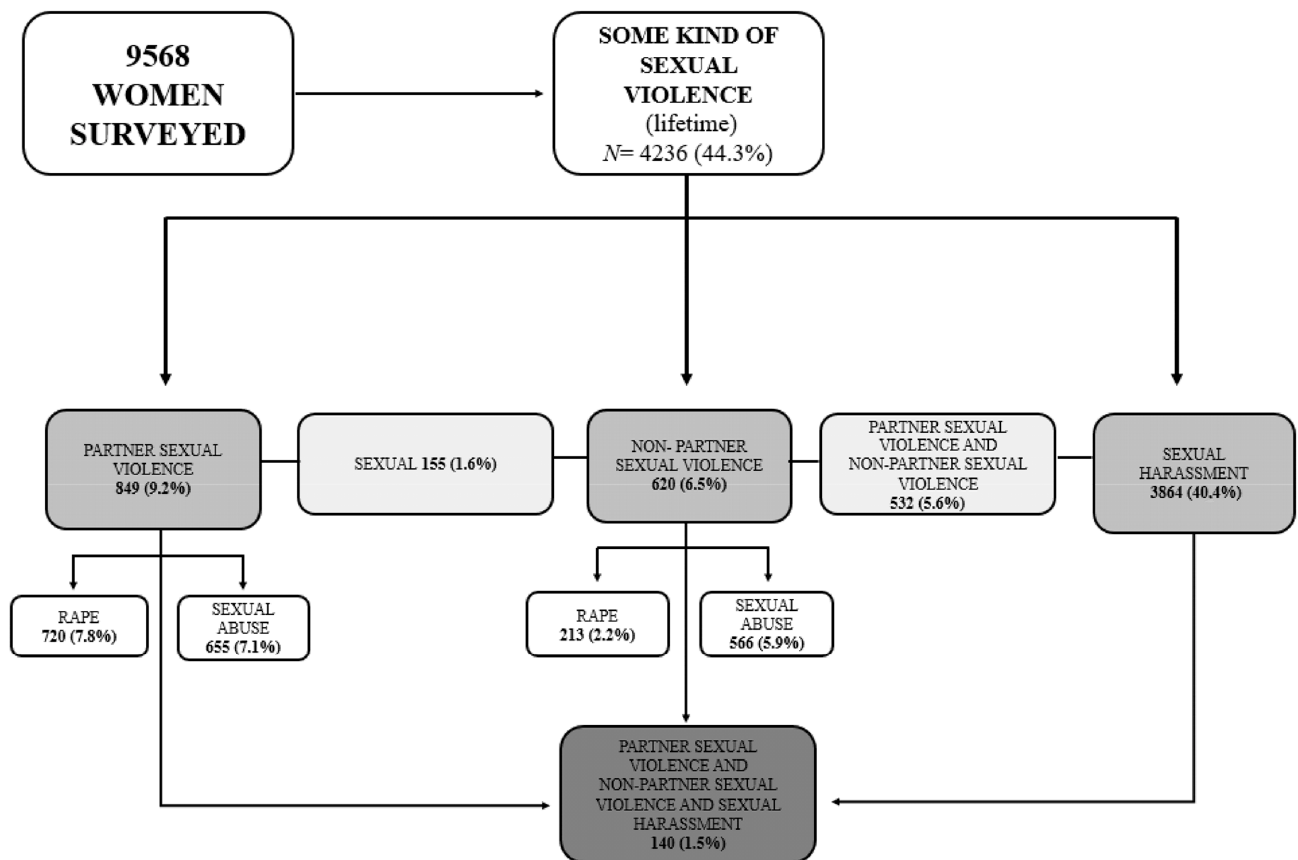
Figure 1. Frequency and combinations of sexual violence: Partner Sexual Violence, Non-Partner Sexual Violence and Sexual Harassment.